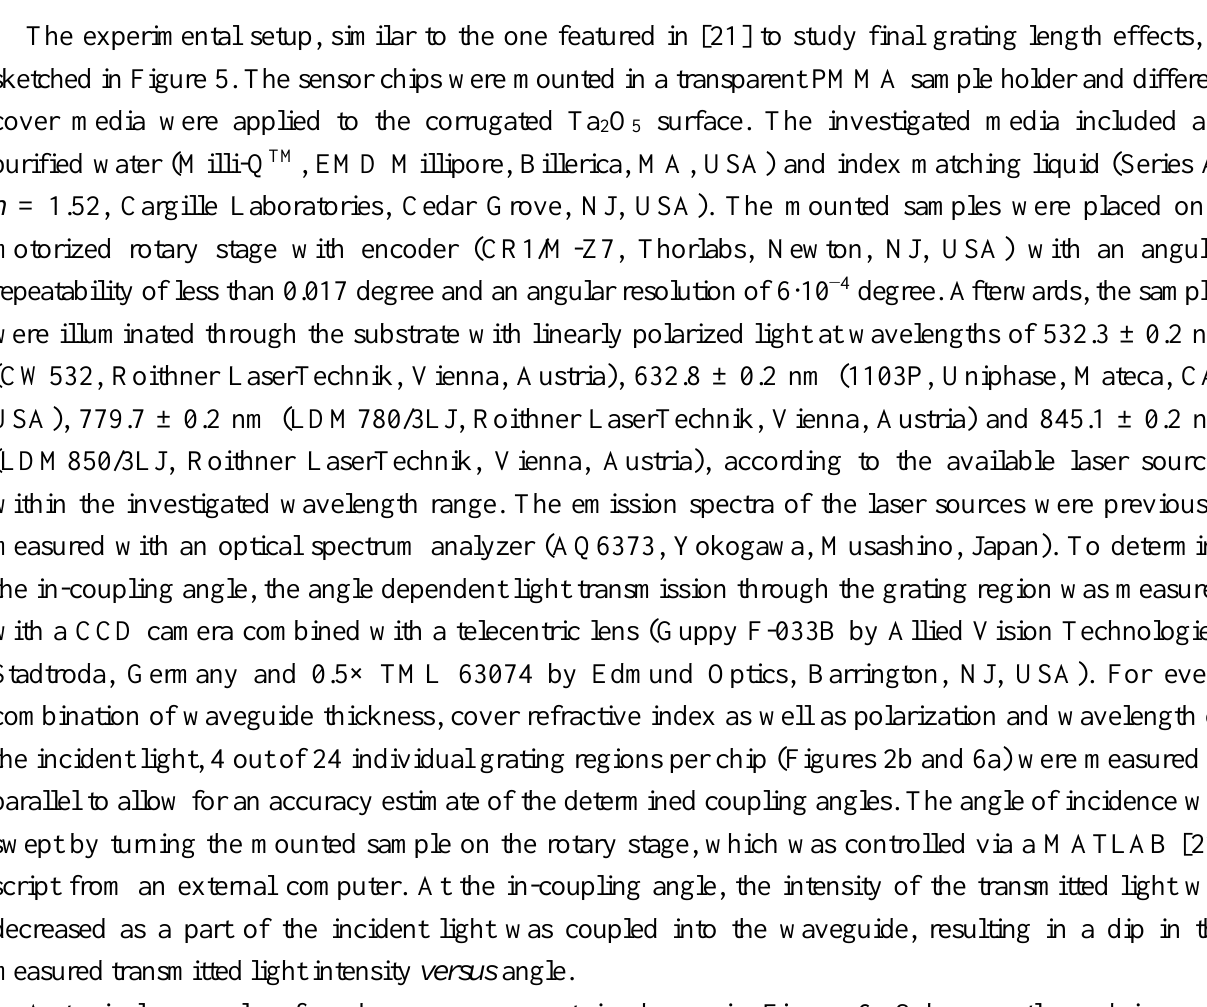
Figure 4. By atomic force microscopy (AFM) measured profile of the grating after ( a ) and before ( b ) deposition of ~300 nm Ta 2 O 5 , together with a topographical scan of the grating ( c ) after deposition. Due to the small aspect ratio of the grating ( h g << Λ ), the structure of the grating is mostly conserved also for thicker Ta 2 O 5